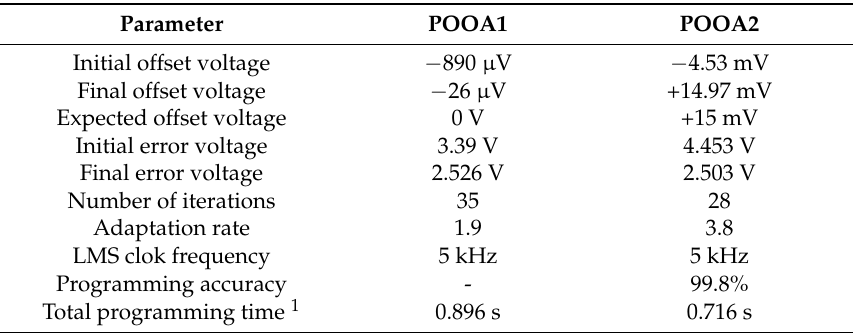
Table 2. Summary of LMS programming